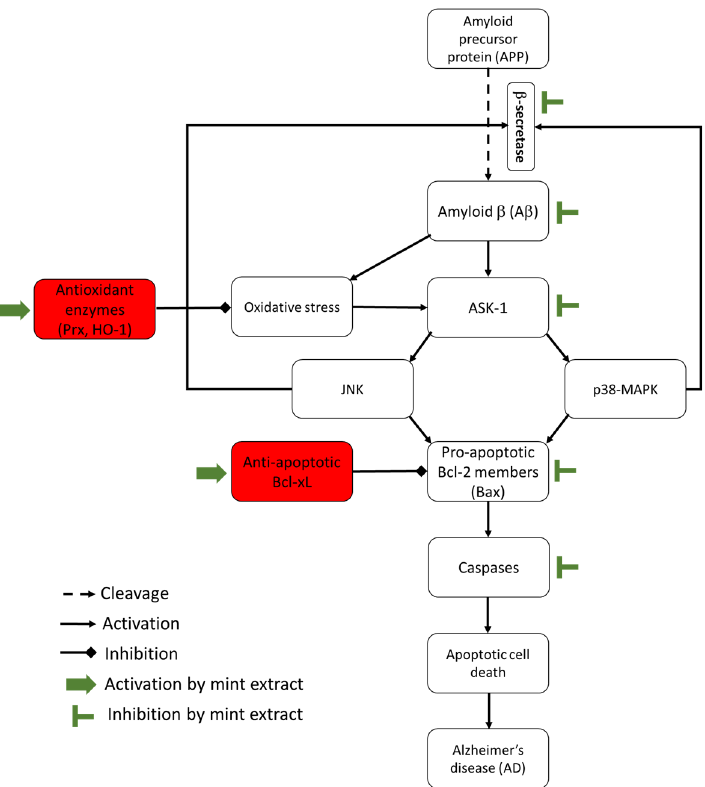
Figure 7. This relatively simplistic diagram summarises the potential effects of mint extracts on the pathways leading to development of Alzheimer’s disease (AD).